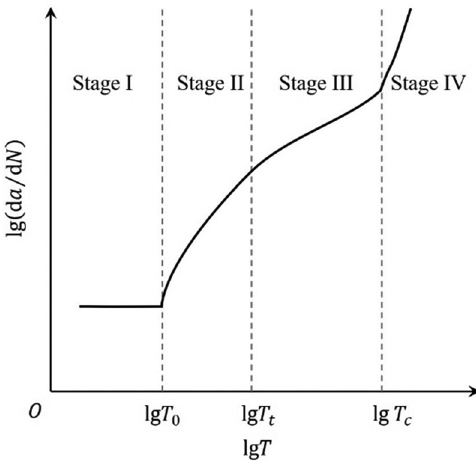
Figure 5: Lake – Lindley ’ s crack growth model of rubber materials. Adapted with permission from ref. [ 160 ]